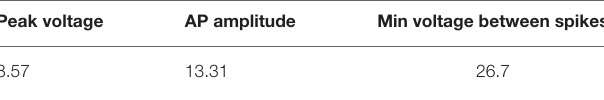
Frontiers in Big Data |